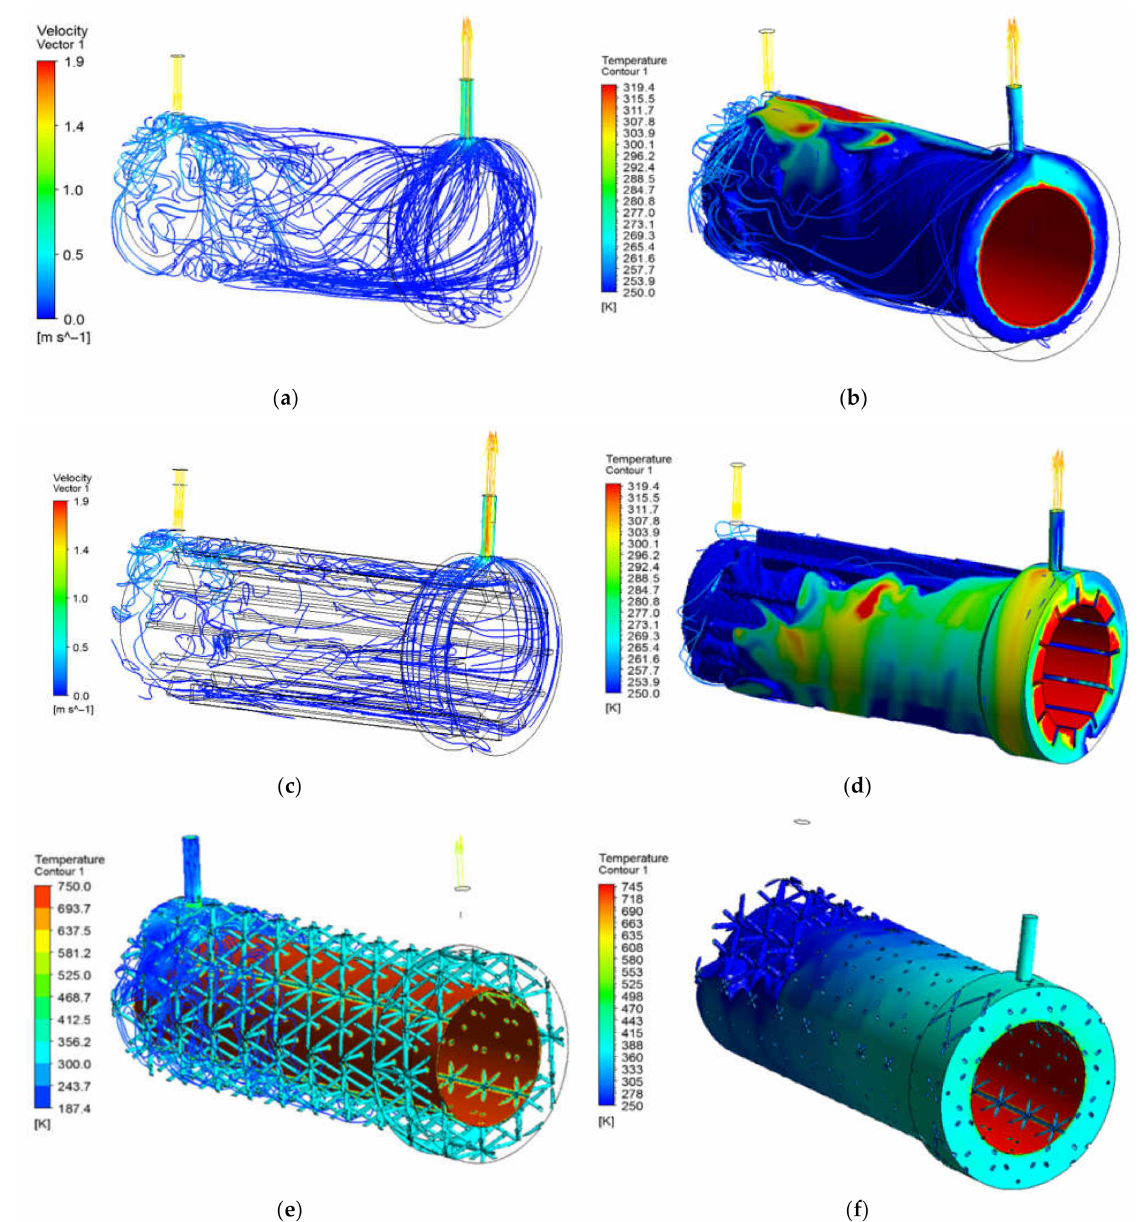
Figure 11. Fully developed flow and high-temperature fluid